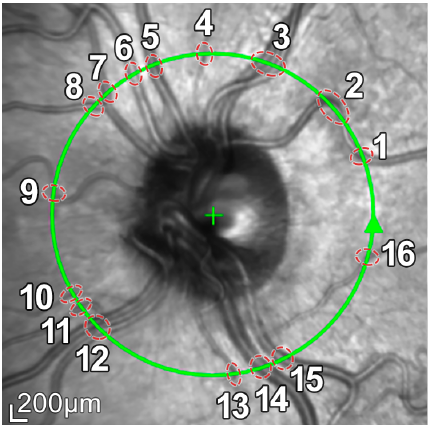
Figure 5. Retinal fundus imaging of the eye under analysis. The green circumference represents the OCT analysis circumference centered on the optic nerve, marked with a + . The numbers represent the vessels crossing this analysis